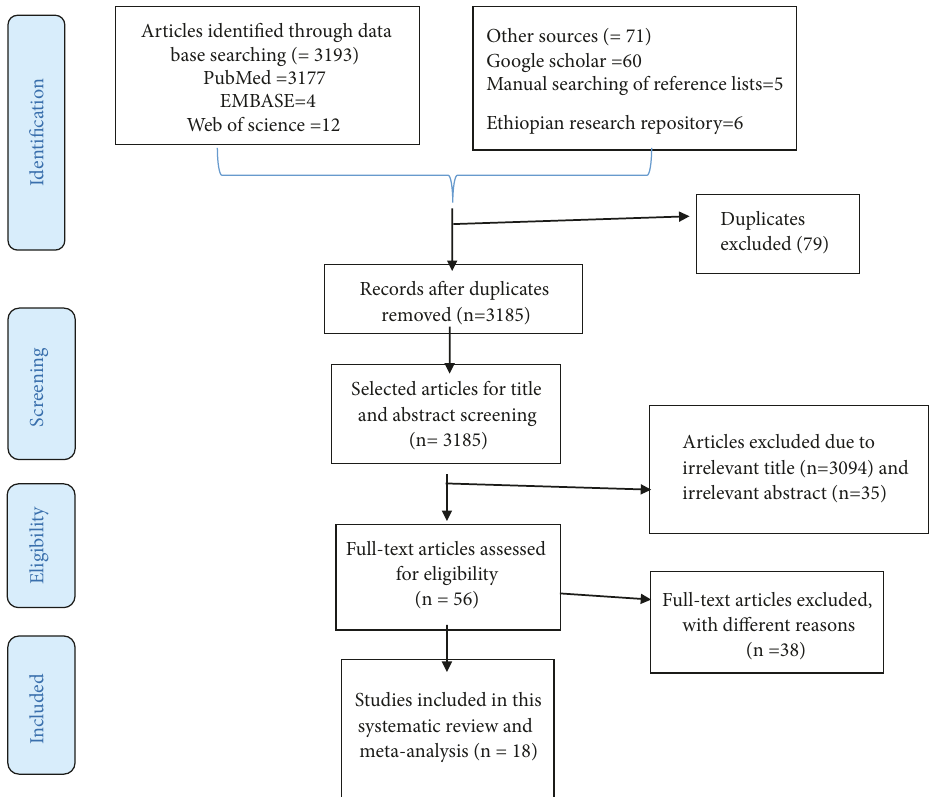
Figure 1: A PRISMA flow diagram of articles screening and process of